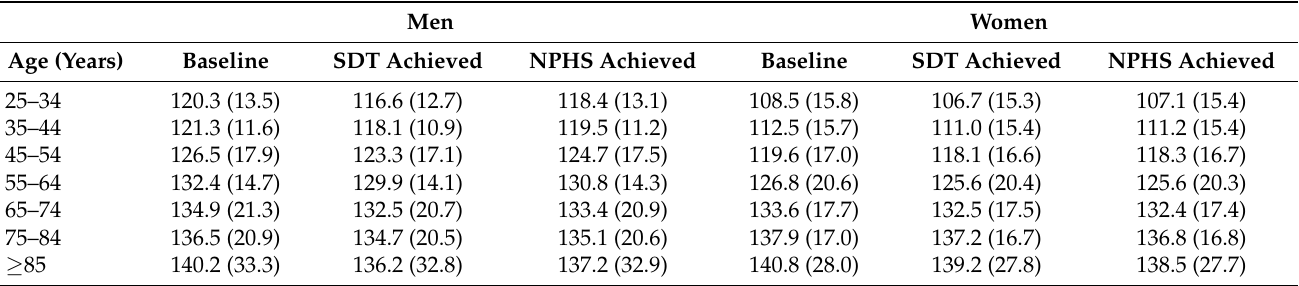
Table 1. Estimated changes in mean systolic BP if the national sodium reduction targets were achieved by